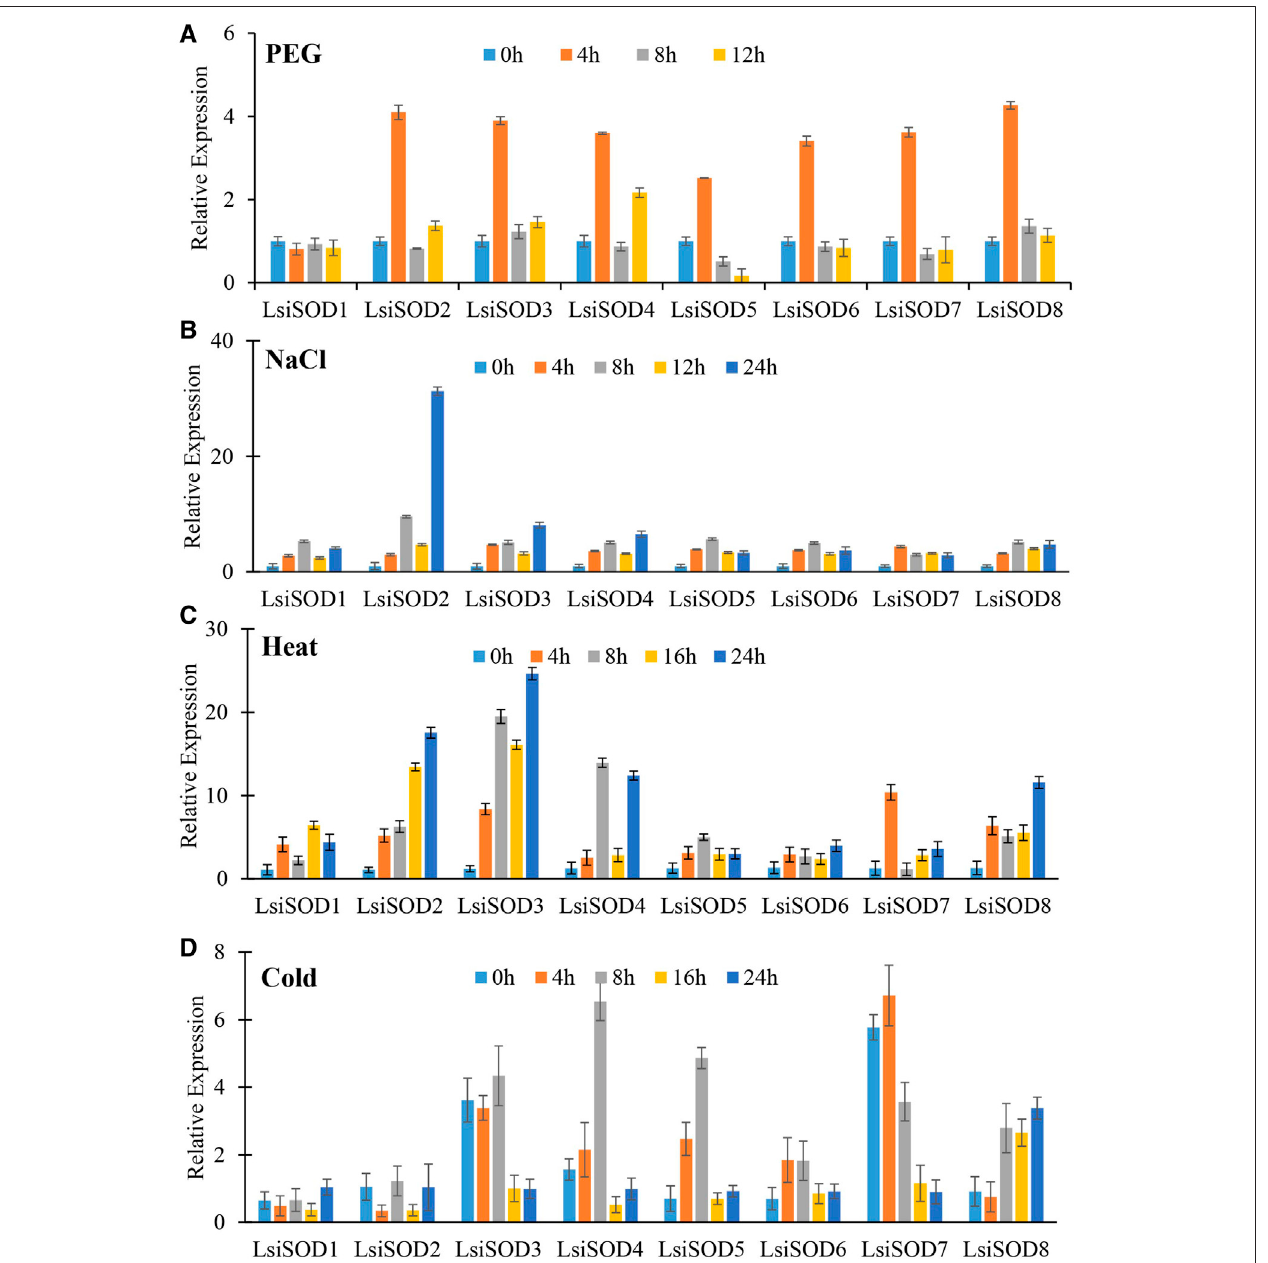
FIGURE 11 | qRT-PCR study of SOD genes of bottle gourd in response to different abiotic stresses including (A) heat, (B) cold, (C) PEG, and (D) NaCl at different time points (0, 4, 8, 16, 24 h). Error bars indicate ±SD based on three biological replicates.